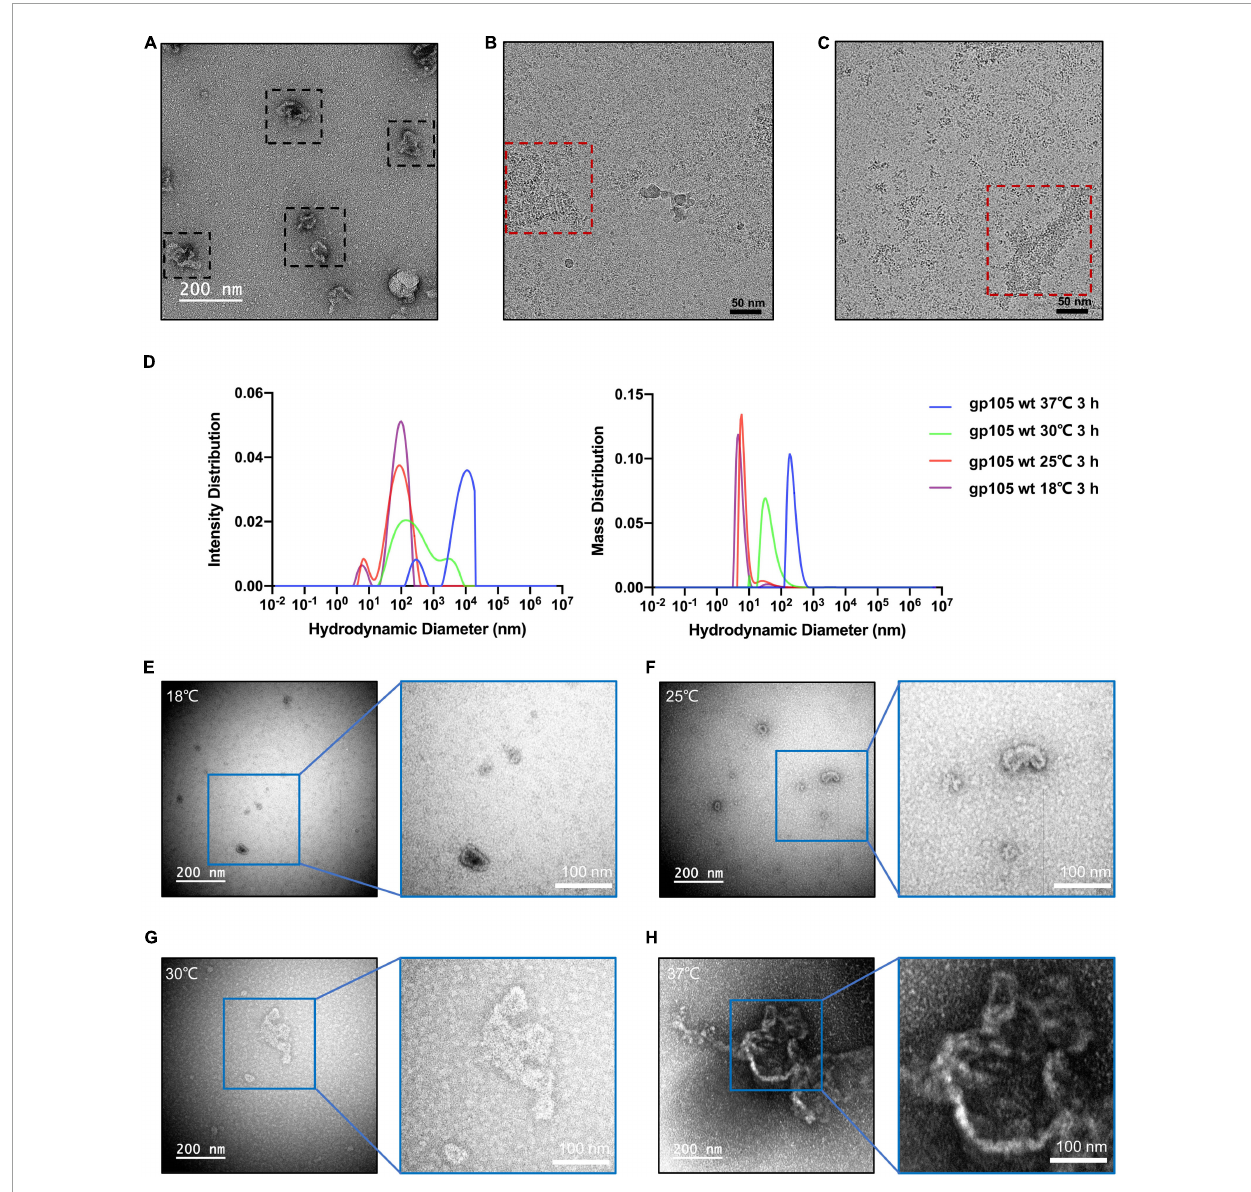
FIGURE6 In vitro self-assembly of gp105 under different temperatures. (A) A representative negative-staining micrograph showing the aggregations generated from gp105 monomers after an incubation of 24 h at 18 ◦ C. (B) A representative cryo-EM micrograph showing the lattice-like aggregations generated from gp105 monomers after an incubation of 3 h at 18 ◦ C. (C) A representative cryo-EM micrograph showing the aggregations generated from gp105 monomers after incubation at 30 ◦ C for 3 h. (D) Dynamic light scattering analysis of the gp105 monomer after incubation for 3 h at different temperatures. The intensity distribution of the gp105 monomer at different temperatures shows the different polymorphic forms in the solution. The mass distribution of the gp105 monomer at different temperatures shows the proportion of different polymorphic forms in the solution. (E–H) The representative negative-staining micrographs of gp105 monomer after incubation at 18 ◦ C (E) , 25 ◦ C (F) , 30 ◦ C (G) , and 37 ◦ C (H) for 3 h.